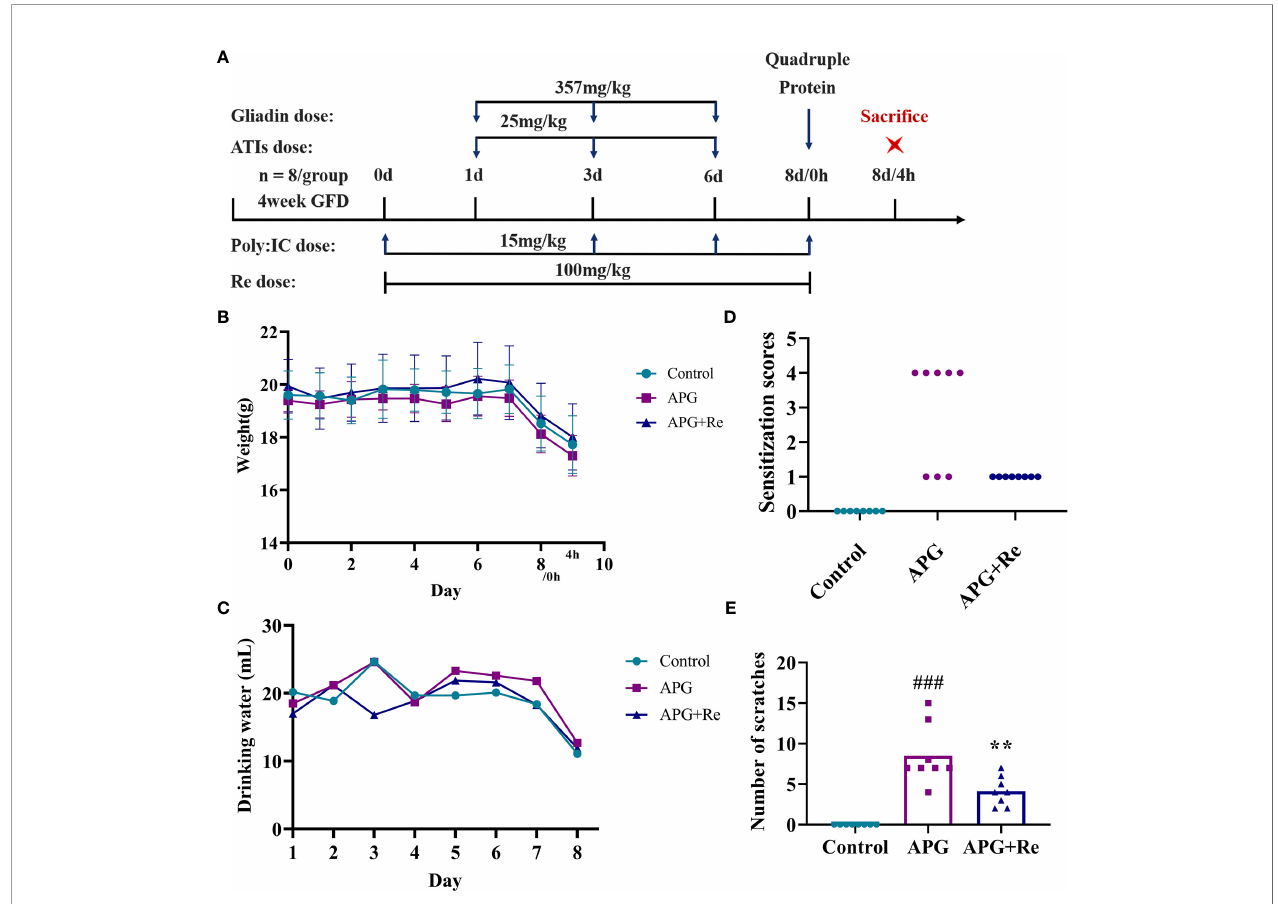
FIGURE 3 | Resveratrol intervenes in the clinical symptoms of the mice with celiac disease. (A) Nutritional intervention of resveratrol in the mice with celiac disease. (B) Weight of mice. (C) Water consumption of mice. (D) Clinical symptoms of mice. (E) Number of scratches in mice. # Indicated statistically signi fi cant differences when compared to the control group. ### P < 0.001. * Indicated statistically signi fi cant differences when compared to the APG group. **P < 0.01. Symptom scoring: (0) No symptoms; (1) Scratching nose and mouth; (2) Swelling around the eyes and mouth, diarrhea, reduced activity or walking in place, higher breathing rate; (3) Shortness of breath, wheezing, blue rash around the mouth and tail; (4) Loss of consciousness, tremors or cramps, blood in stool; (5) Death by